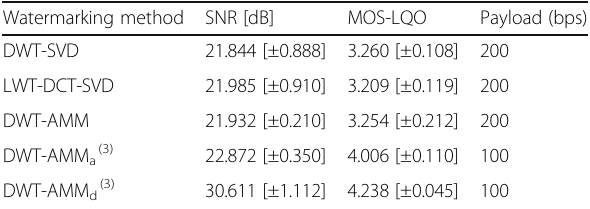
Table 4 Statistics of the measured SNRs and MOS-LQO scores. The data in the second and third columns are interpreted as “